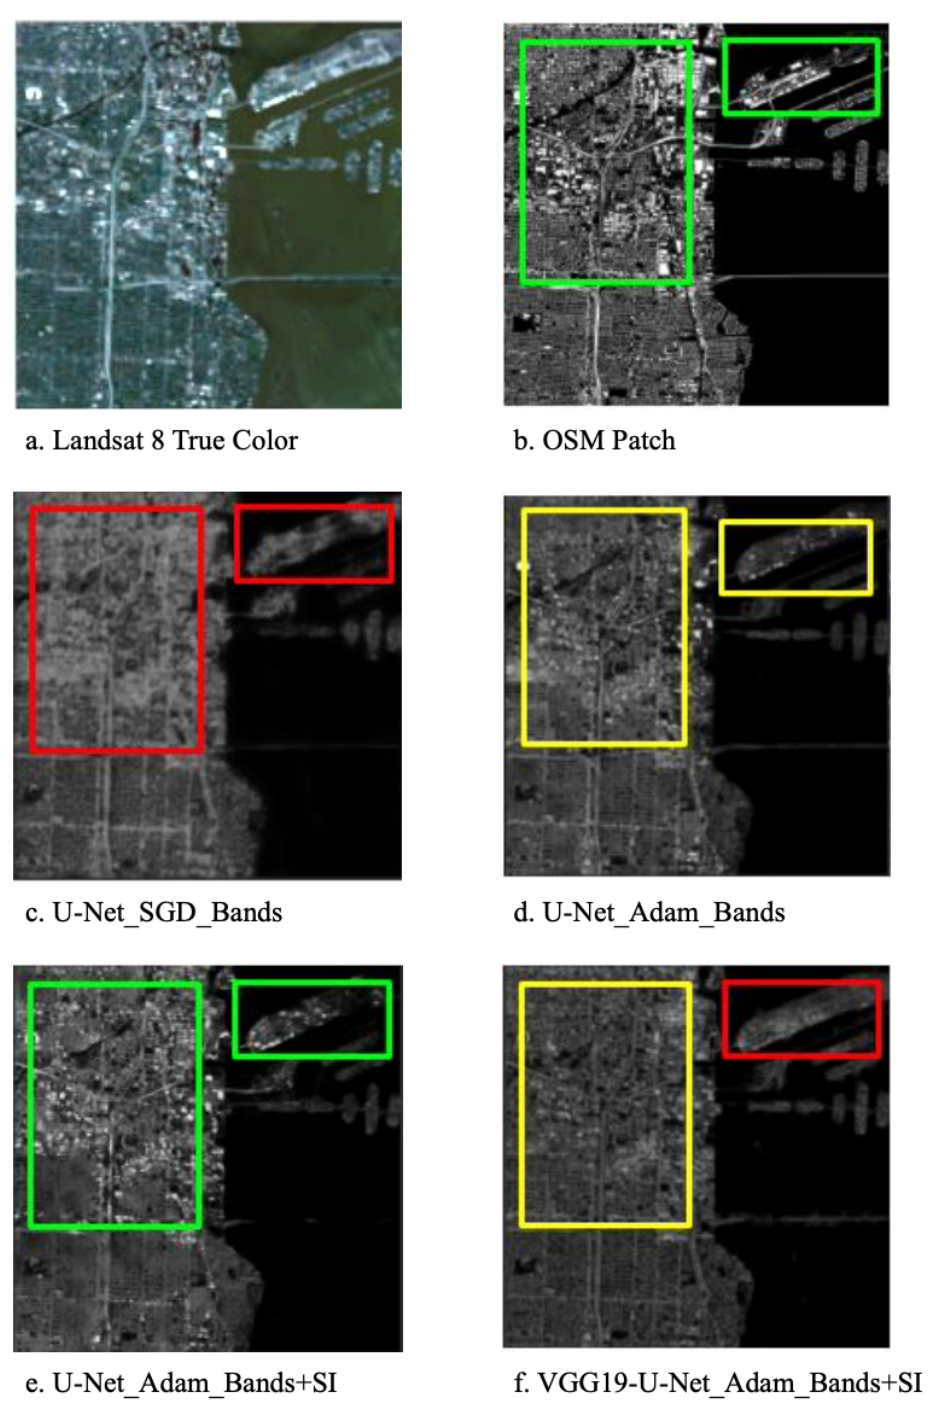
Figure 8. Impervious surface predictions from the four deep learning models on another image representing an urban